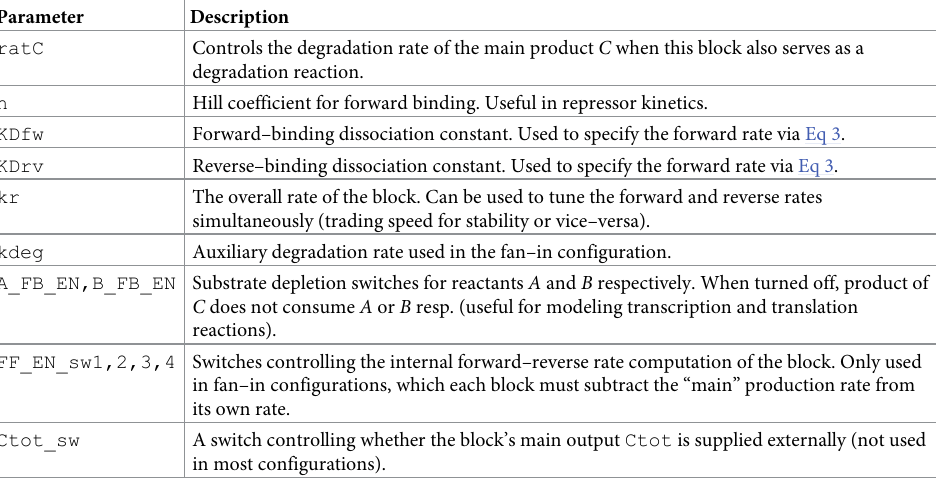
Table 2. Tunable parameters for each block. Parameter Description ratC Controls the degradation rate of the main product C when this block also serves as a degradation reaction. n Hill coefficient for forward binding. Useful in repressor kinetics. KDfw Forward–binding dissociation constant. Used to specify the forward rate via Eq 3. KDrv Reverse–binding dissociation constant. Used to specify the forward rate via Eq 3. kr The overall rate of the block. Can be used to tune the forward and reverse rates simultaneously (trading speed for stability or vice–versa). kdeg Auxiliary degradation rate used in the fan–in configuration. A_FB_EN,B_FB_EN Substrate depletion switches for reactants A and B respectively. When turned off, product of